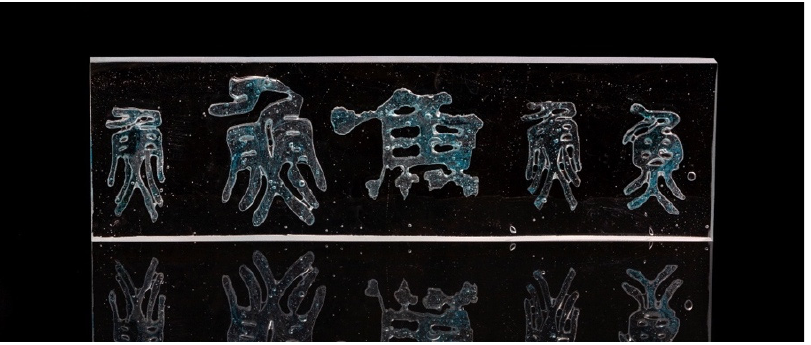
Figure 21. Dian Shi, Pictography series—Fish III , 2018. Water jet cut glass, with glass, oxides, and bubble inclusions. Courtesy of the artist, used with permission.